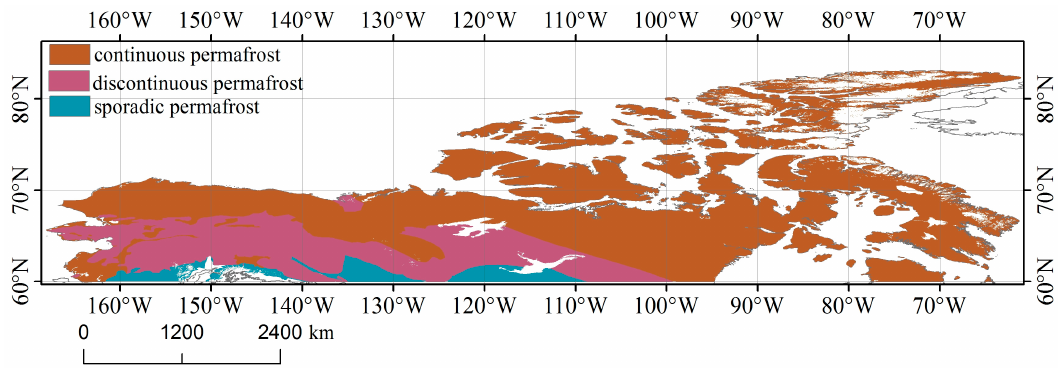
Table 2. The correlation analysis.